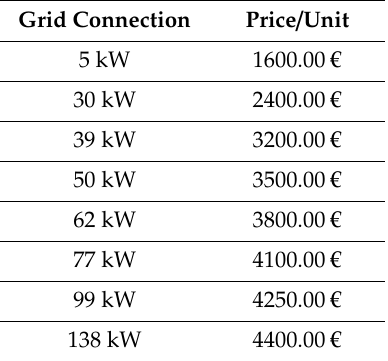
Table 2. Cost for grid